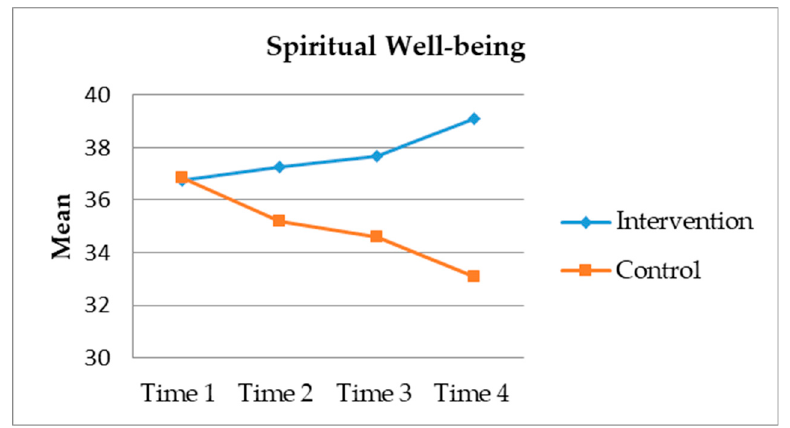
Figure 1. The differences of the mean scores of spiritual well-being between the control (n = 59) and the intervention (n = 53) groups at Time 1, Time 2, Time 3, and Time 4.